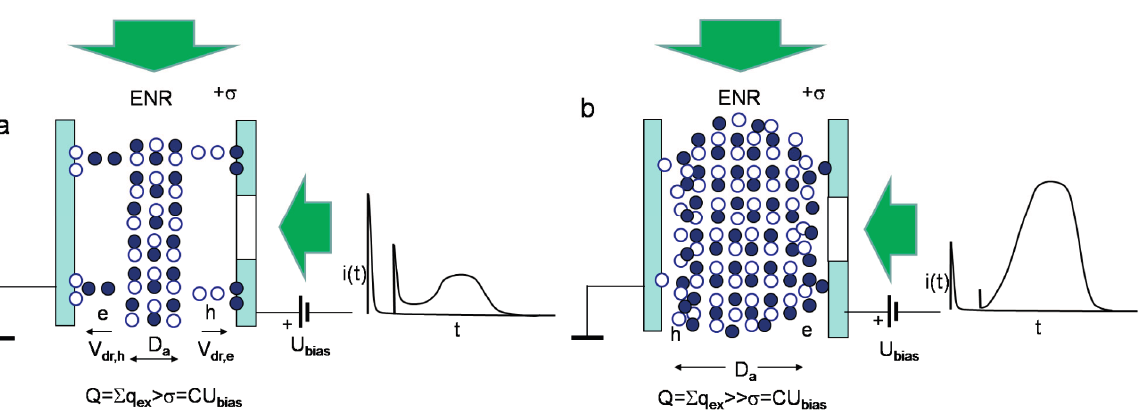
Figure 5. Sketch of separation and drift of the light locally injected charges (of rather small amount) under switched-on external voltage of value capable to separate excess carrier pairs. Here, energy band diagram is skipped. This sketch illustrates the drift prevailing processes at moderate and high applied voltages. The main notifications and assumptions are the same as for Figure 3. On the right, a diagram of capacitor charging and of drift current pulses is sketched.